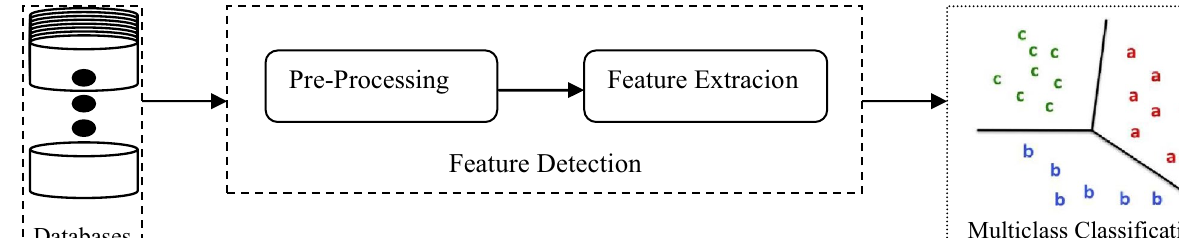
Figure 2. Basic overview of a general recognition system.